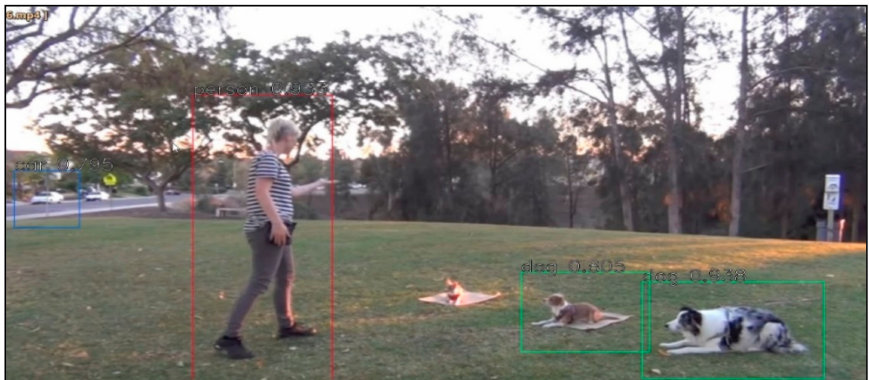
Figure 7. Faster-region based convolution neural network (RCNN)